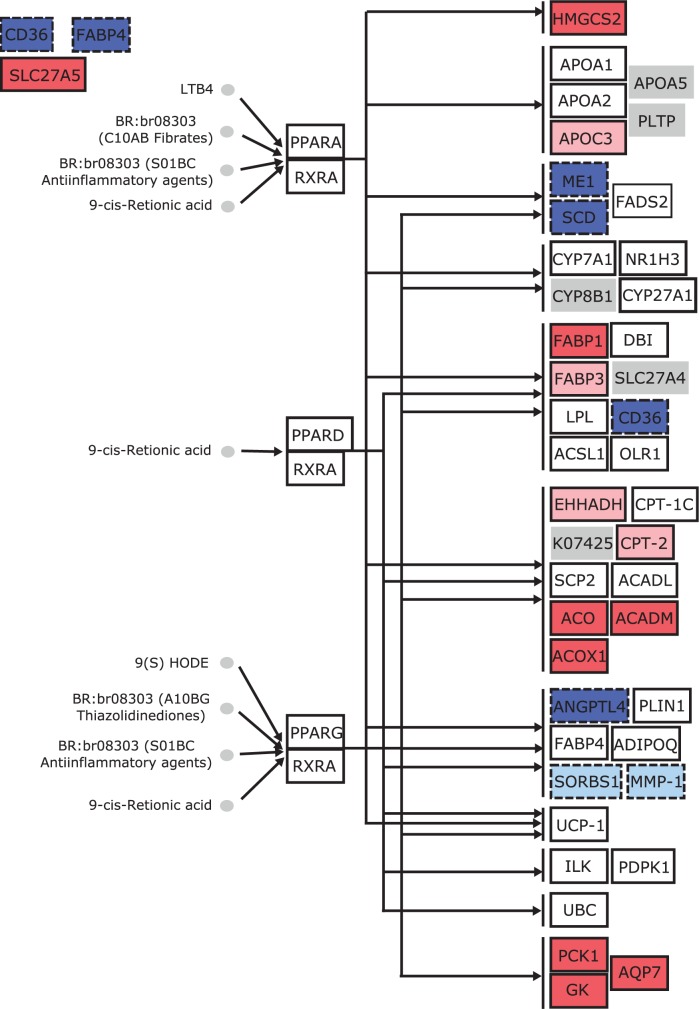
PPAR signaling pathway from KEGG. The nodes correspond to genes and other functional units, and edges represent interactions between those units. Nodes are colored based on their differential expression between case and control samples detected with ROTS in the ccRCC data set GSE14994. Solid borders indicate that the gene is highly expressed in ccRCC patient samples, and correspondingly dashed borders mean low expression compared with control samples. If FDR value of the node is ≤0.05, the color of the node is strong. The color is light if the FDR value is between 0.05 and 0.1. Genes with white node color have FDR value >0.1. For gray nodes without borders, there are no measurements available. A colour version of this figure is available at BIB online: http://bib.oxfordjournals.org.